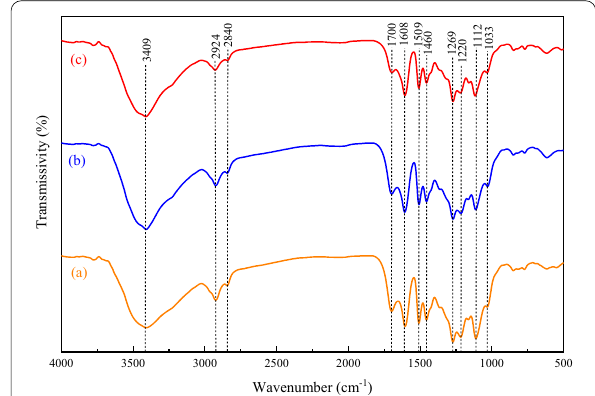
Fig. 11 Infrared spectra of the lignin samples extracted from palm fibers under different processing conditions: a optimal conditions; b conditions of 90 min, 170 °C, 70% ethanol, 1/20 g/mL solid/liquid ratio; and c conditions of 90 min, 190 °C, 70% ethanol, 1:15 g/mL solid/liquid